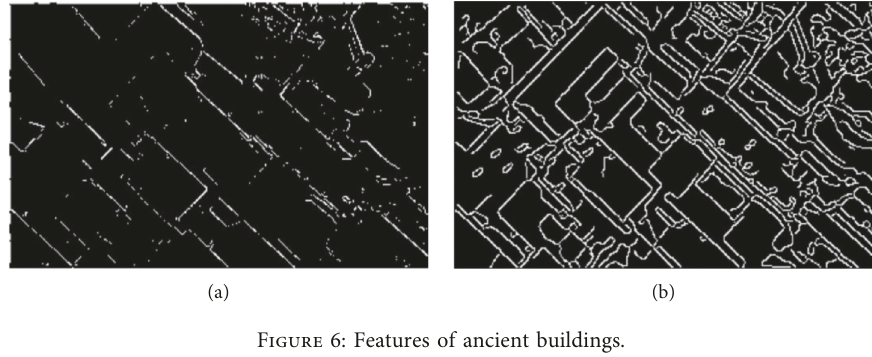
Figure 6: Features of ancient buildings.